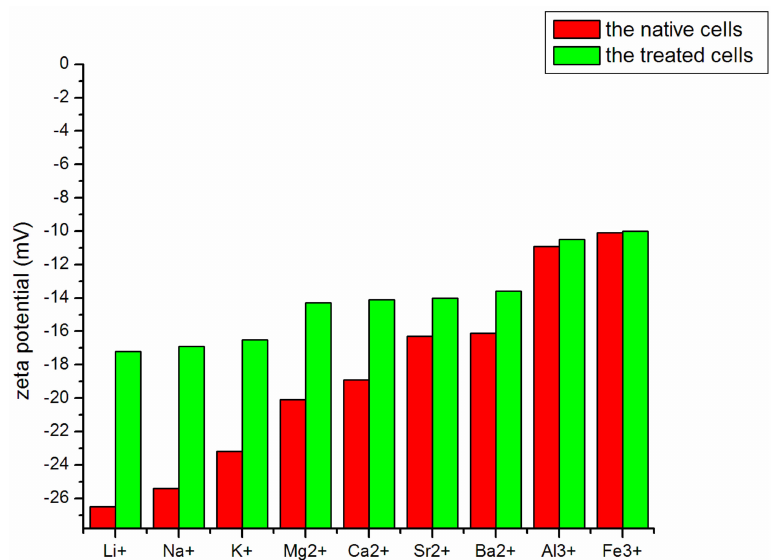
Figure 6. Zeta potential of M. aeruginosa cells after addition of different